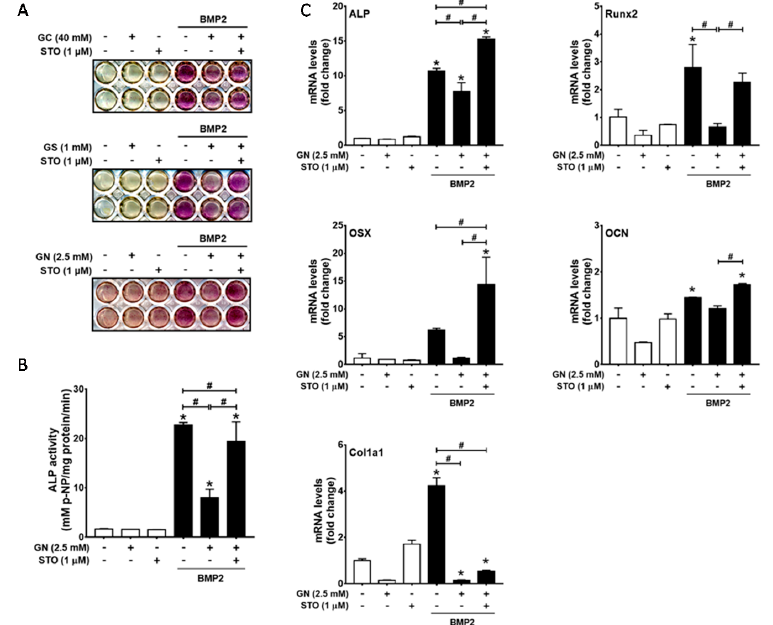
Figure 2. OGT activity inhibition by STO45849 (STO), an OGT inhibitor, rescued BMP2-induced ALP activity and osteogenic marker gene expression under excessive O -GlcNAcylation-inducing conditions. C2C12 cells were incubated for 48 h in the presence or absence of the indicated reagents, and osteogenic differentiation was examined by ALP staining ( A ); ALP activity assays ( B ); and qRT-PCR analysis of osteoblast differentiation marker genes ( C ). * p < 0.05 compared with the non-treatment control; # p < 0.05 for the indicated pairs.